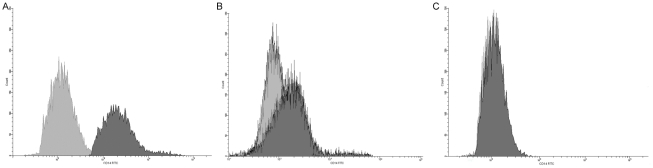
FACS analysis of cell surface CD14 expression on primary human ATII cells, immortalised TT1 cells and A549 cells.Cells were immunostained with FITC-labelled anti CD-14 antibody and expression measured using flow cytometry. Representative hisotgrams demonstrate that ATII cells (A) and TT1 cells (B) express CD14 whereas A549 cells (C) do not.